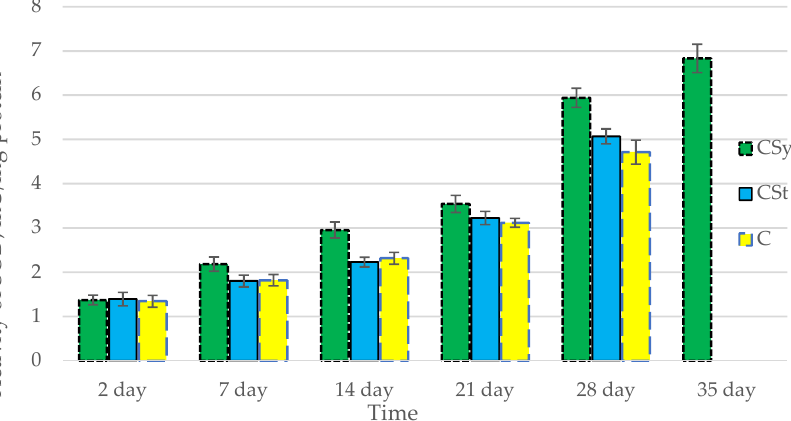
Figure 2. Activities of Superoxide Dismutase (SOD) in the 2-,7-,14-,21-,28-,35-day-old honey bees’ hemolymph after two methods of supplementation with hemp extract: C–control (pure sugar syrup), Csy–hemp extract in syrup, Cst–hemp extract on strips. (Two-Way ANOVA: supplementation method: F (2,146) = 66,223, p = 0.0000; days of supplementation: F (4,138) = 1888,5, p = 0.0000; supplementation method × days of supplementation F (8,138) = 16,781, p = 0.0000.